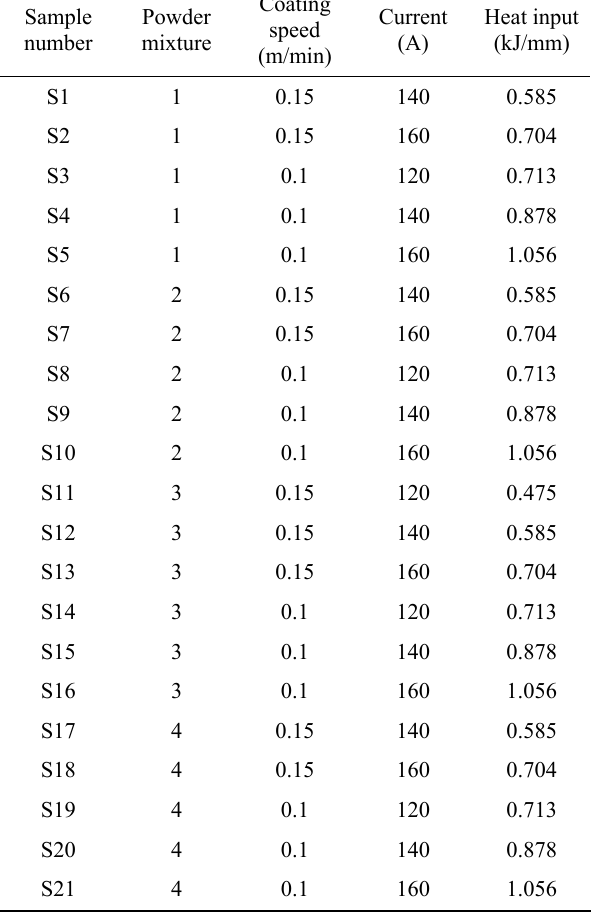
Table 4 Production parameters used in PTA surface coating. Sample